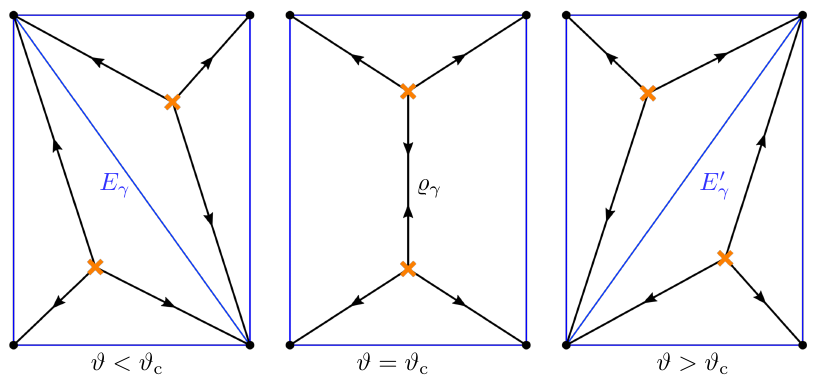
Figure 2 . Changes of the Stokes graph and the triangulation T ϑ as a critical value ϑ The edges of the triangulation are indicated with blue dashed lines. The edge E γ undergoes a flip when ϑ c is crossed. At ϑ = ϑ c the edge E γ cannot be defined due to the presence of % γ which lifts H , Z ) to [ γ ] 1 (Σ ∈